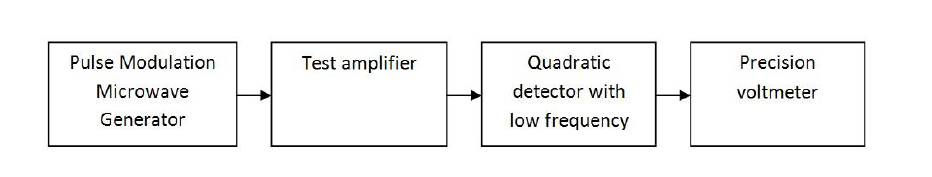
Fig. 3. Block diagram of the installation of the noise level measurement of radiometer